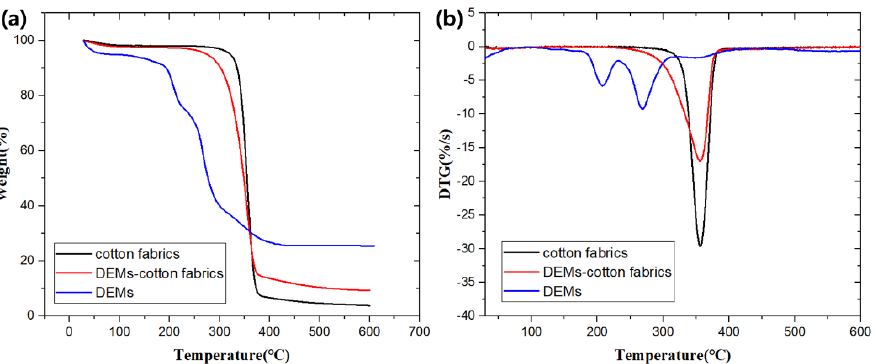
Figure 4. ( a ) Thermo-gravimetric (TG) curves and ( b ) Derivative thermal gravimetry (DTG)curves of pure cotton fabrics, and DEMs-cotton fabrics and DEMs.